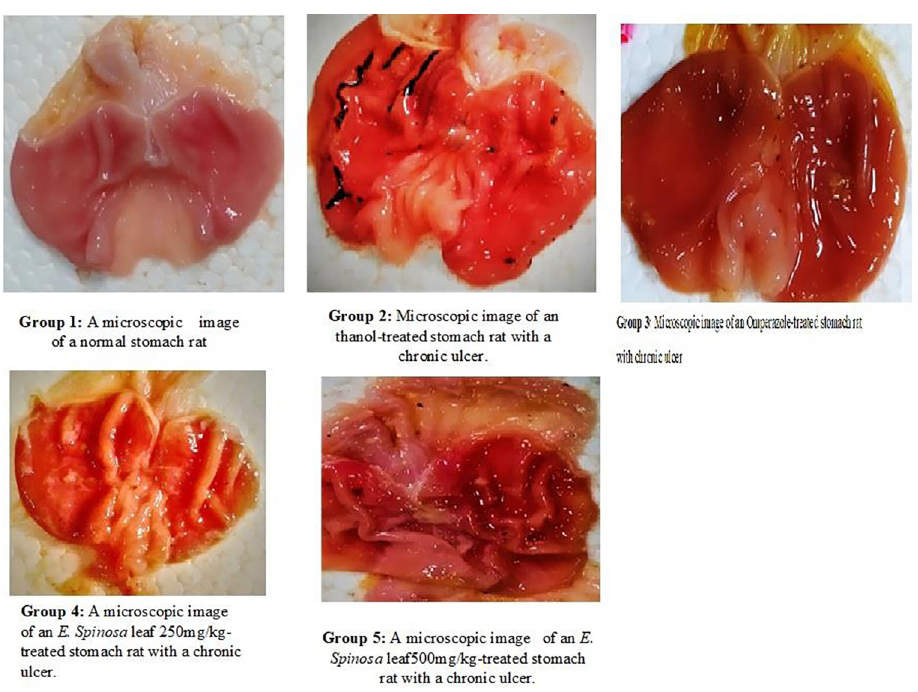
Fig 5. Microscopic evaluation of chronic aspirin -induced gastric ulcer group 1–5 represents the numbers of lesions, red spots, and hemorrhagic streaks.